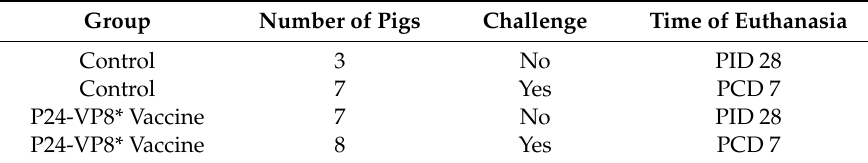
Table 1. Assignment of treatment groups for gnotobiotic (Gn)